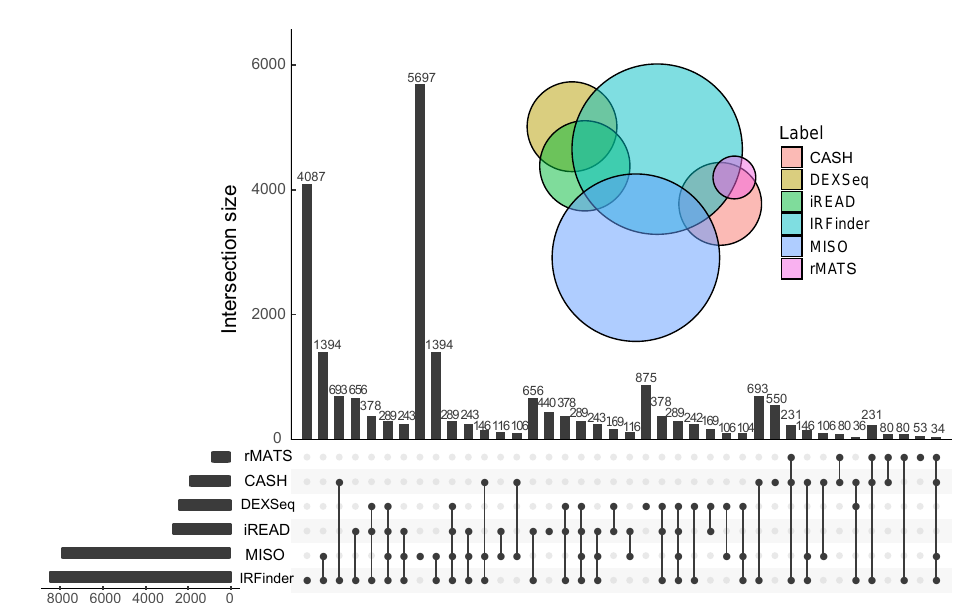
Fig. A2 A combination diagram of Venn and UpSet shows the IR intersection of six methods on SIMU60.